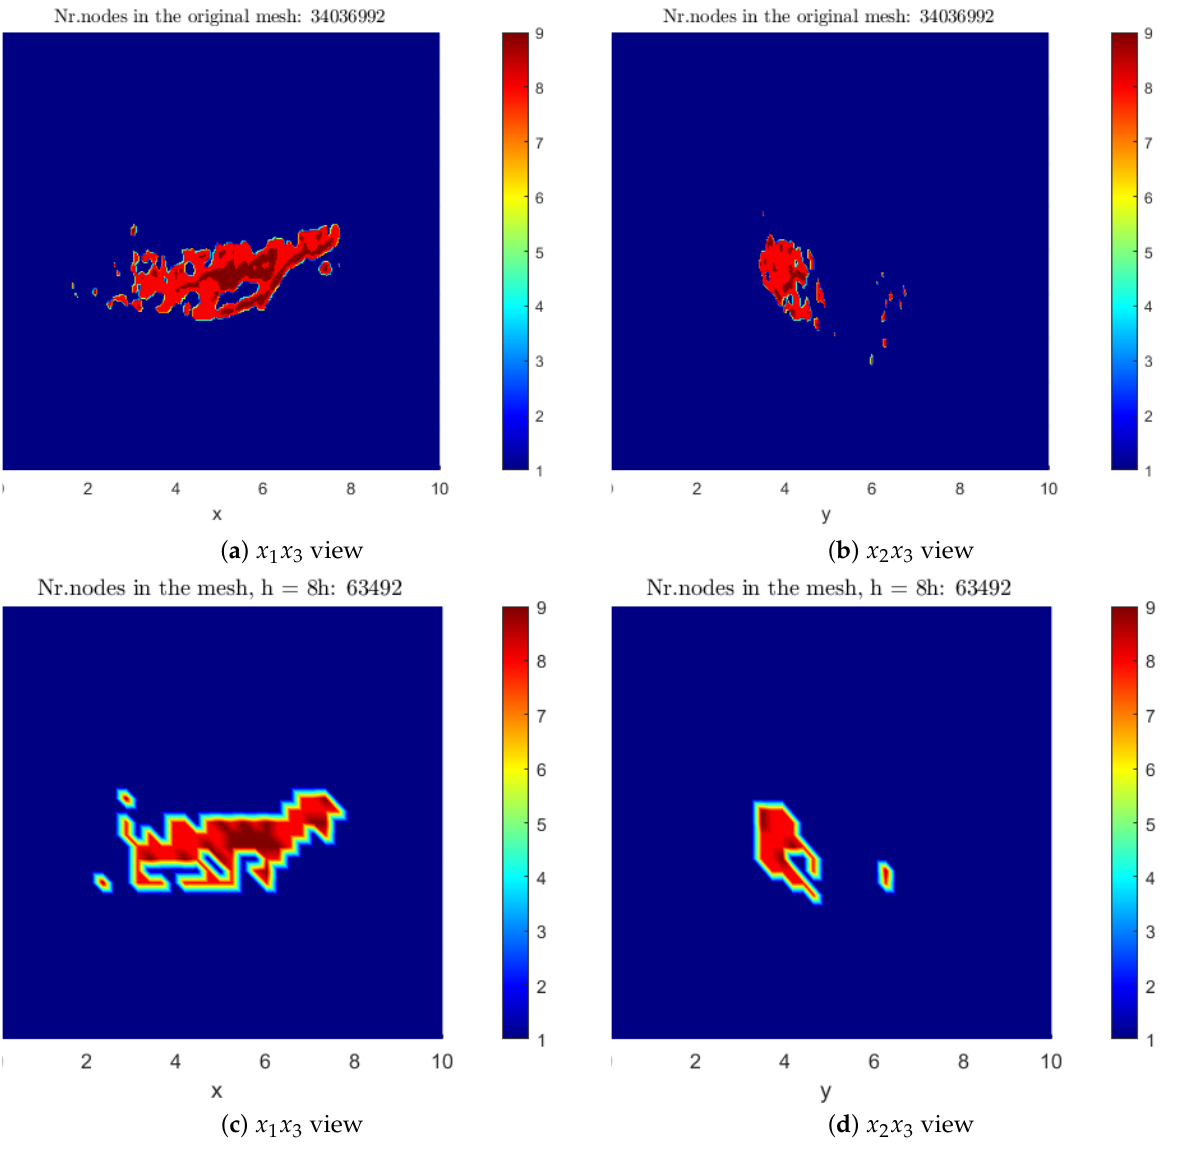
Figure 6. Test 1. Slices of weighted exact ε r ; see Table 1 for description of different tissue types and values of weighted ε r . ( a , b ) Slices on original mesh with mesh size h. ( c , d ) Slices on sampled mesh with mesh size 8